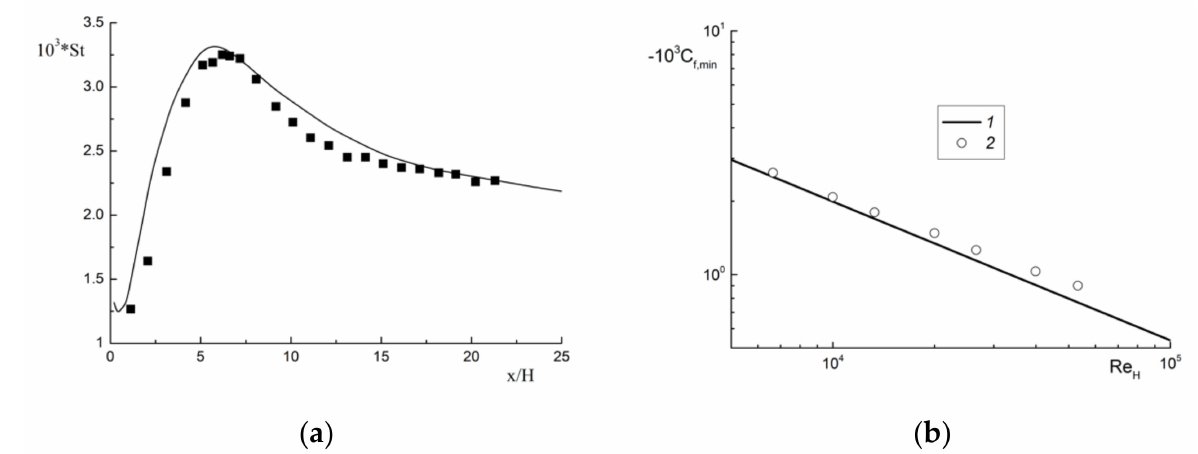
Figure 4. Heat transfer coefficient distributions along the streamwise coordinate ( a ) and minimal wall friction values in the reverse zone vs. Reynolds number ( b ). ( a ): Symbols are the experiments of [36], line is our RANS + SMC “in-house” code simulations. ( b ): 1 is the semi-empirical correlation [37], 2 is our RANS+SMC “in-house” code